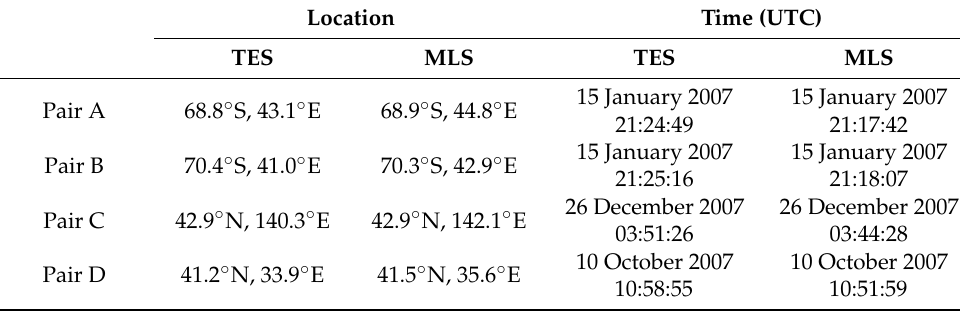
Table 2. Locations and time (UTC) of observations for